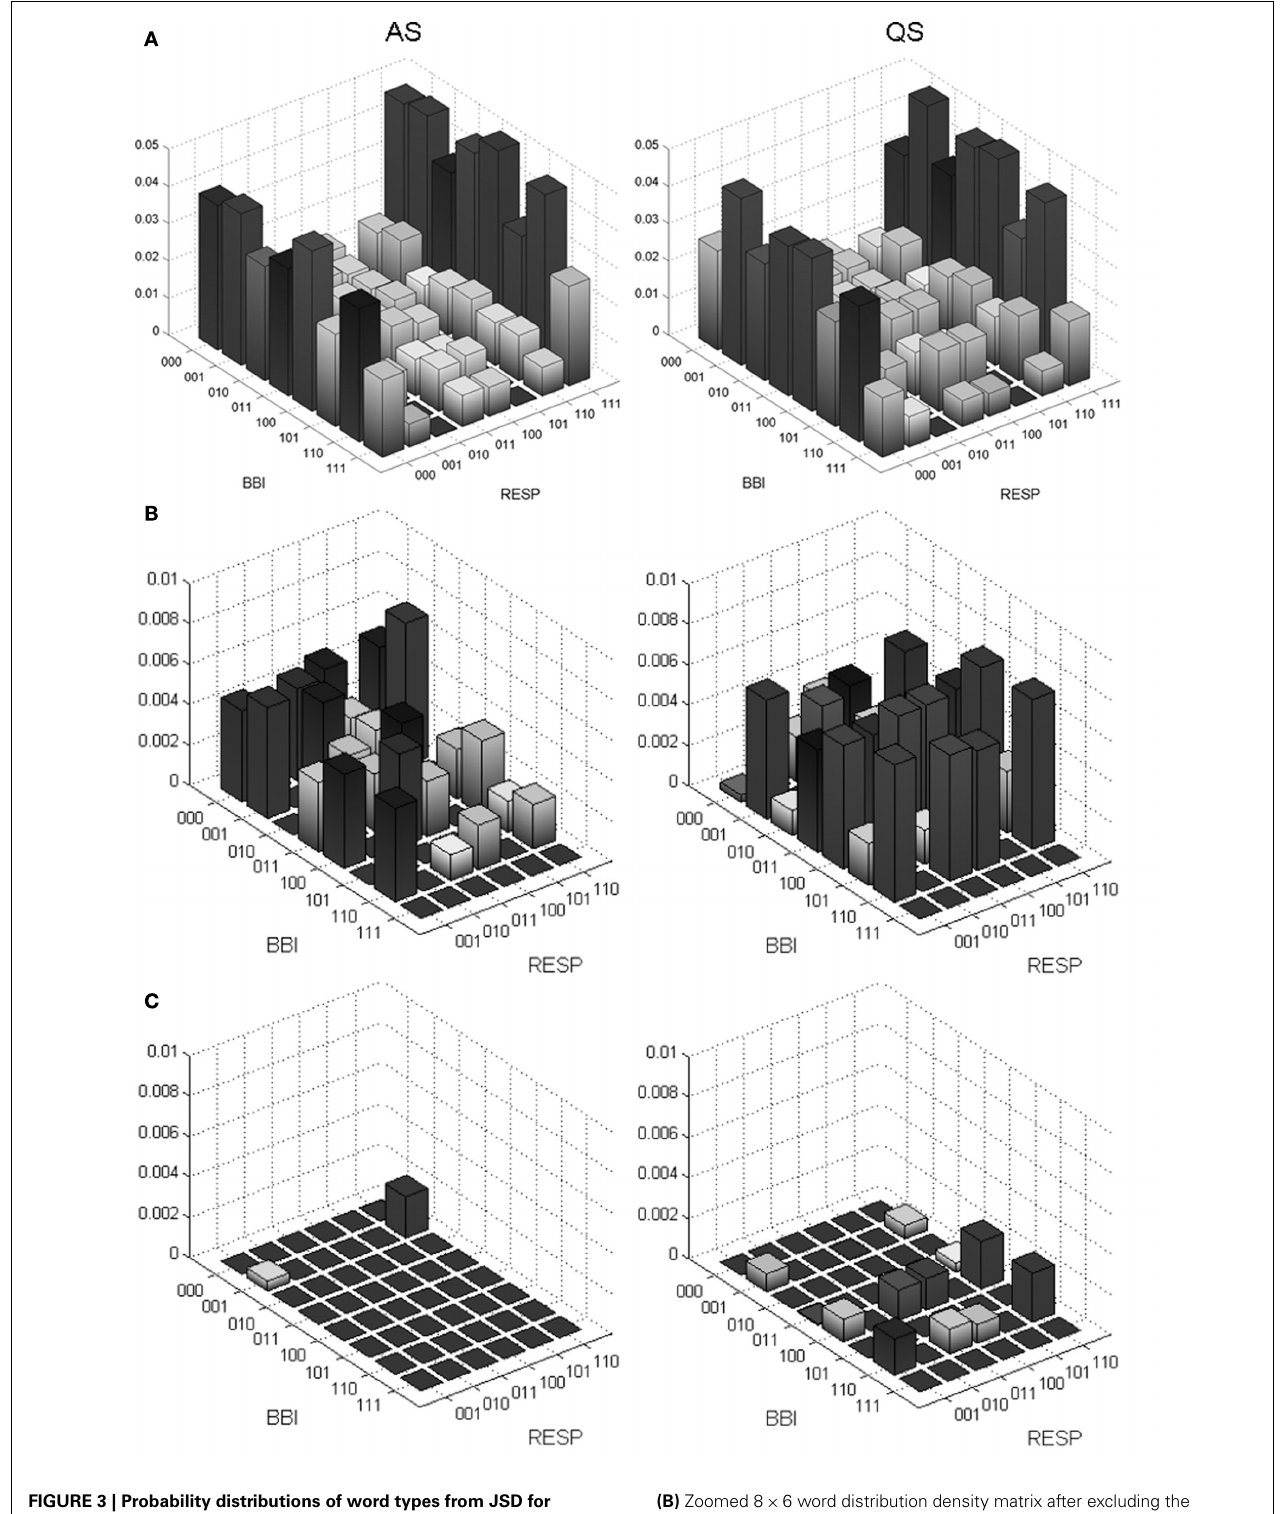
FIGURE 3 | Probability distributions of word types from JSD for cardiorespiratory coupling (BBI, beat-to-beat intervals; RESP, inspiratory interval time series) from preterm newborns during active sleep (AS) and quiet sleep (QS) states. (A) Complete 8 × 8 word distribution density matrix from BBI-000/RESP-000 to BBI-111/RESP-111.